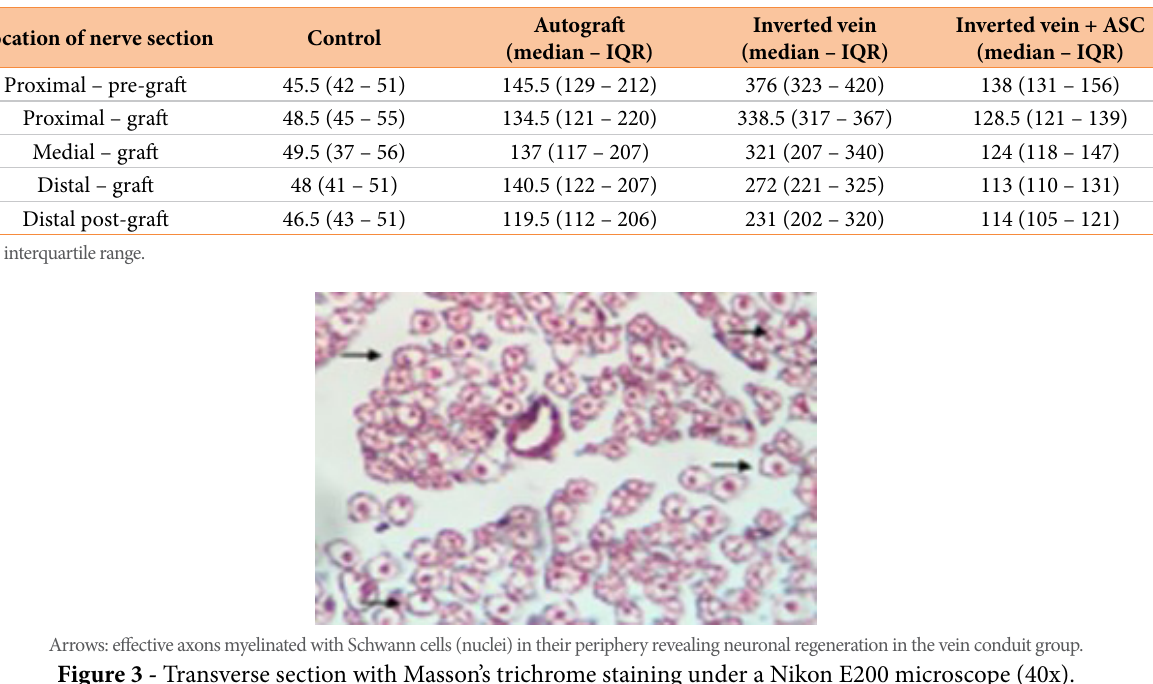
Table 3 - Number of effective axons (Schwann cell nuclei) according to treatment group and location of nerve sections. Values described as median – IQR.